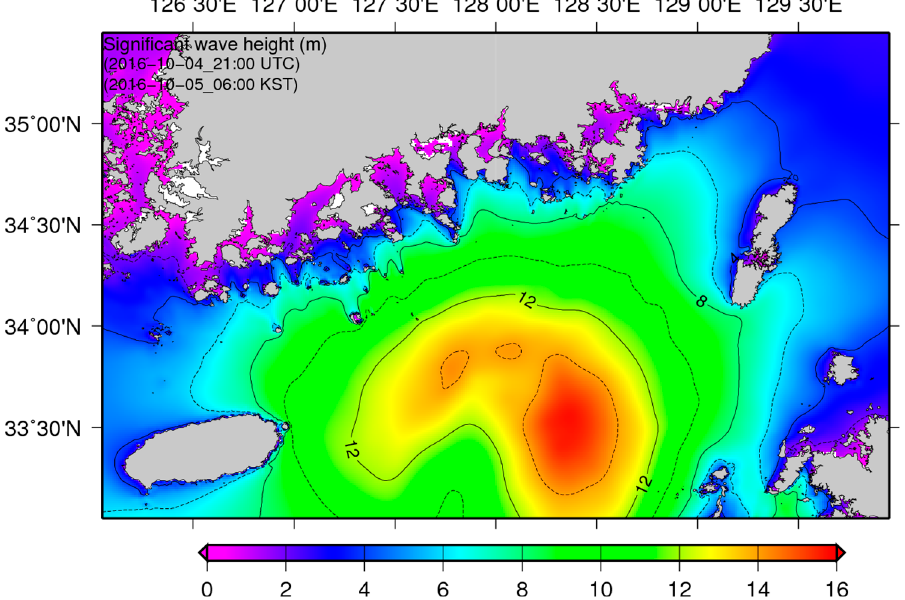
Figure 9. Contour map of simulated significant wave height near the application site .